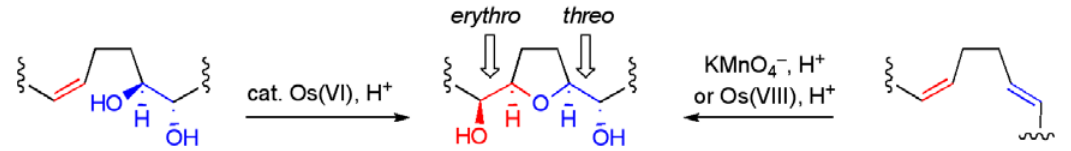
Figure 11. Synthesis of 2,5 cis -disubstituted THF diols by metal oxo mediated oxidative cyclisation.